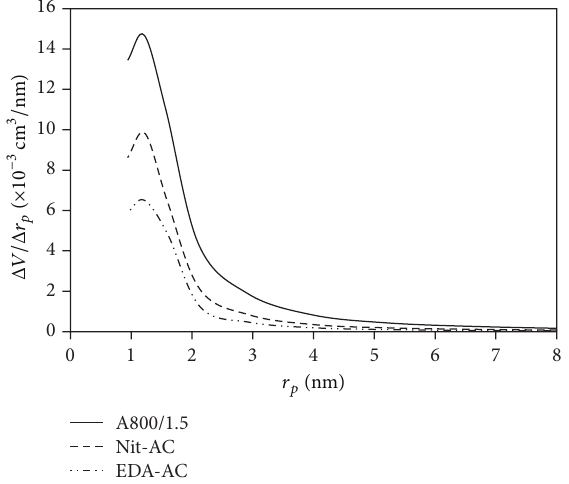
Figure 3: The pore size distribution of activated carbon